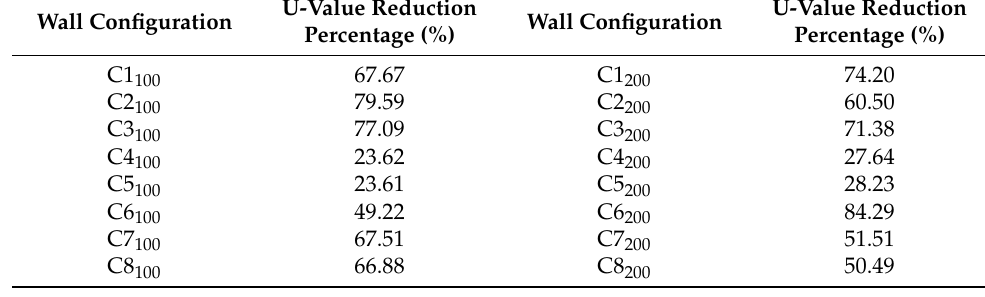
Table 7. The U-value reduction percentages (%) with insulation.